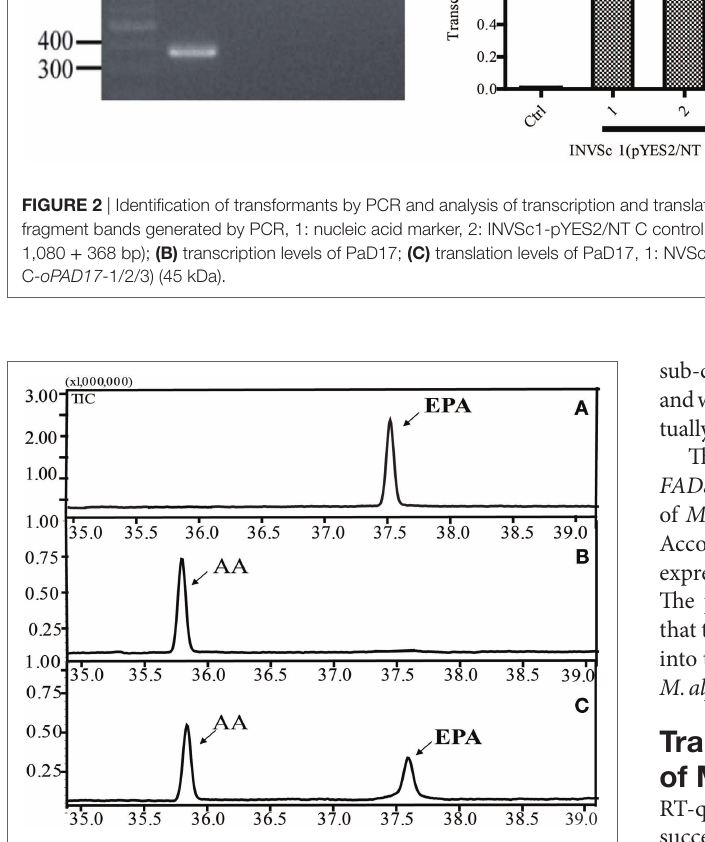
FigUre 3 | Gas chromatogram of fatty acid methyl esters from the lipid fractions of the yeast transformant INVSc 1 (pYES2/NT C- oPAD17 ). (a) EPA standard; (B) INVSc1-pYES2/NT C control strain; (c) INVSc 1(pYES2/NT C- oPAD17 ) strain.